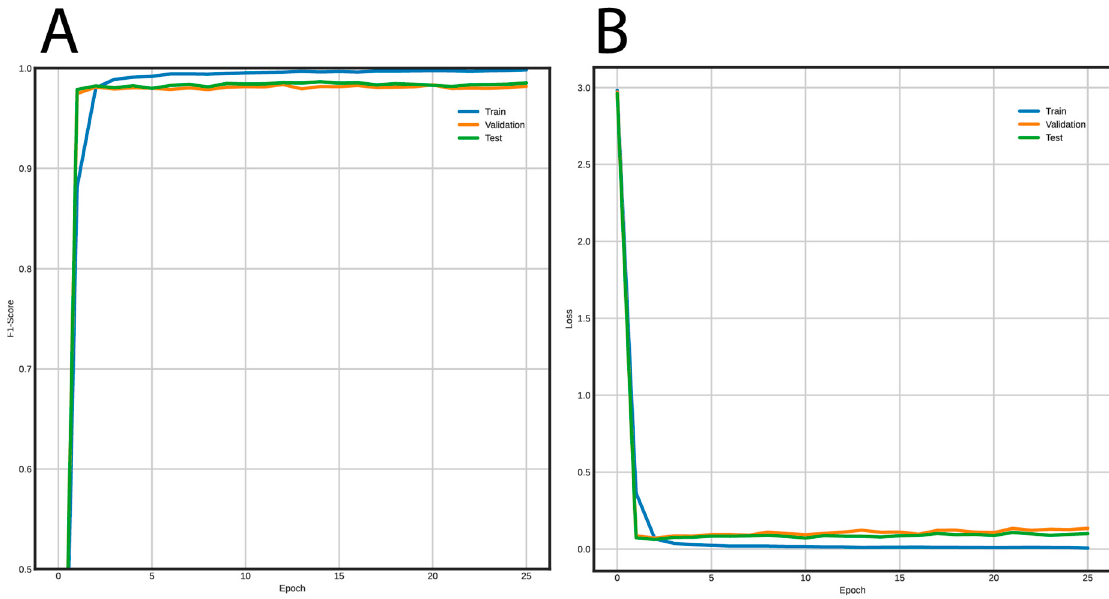
Figure 5. Learning curves using the FNN architecture to classify long terminal repeat (LTR) retrotransposons into lineages. ( A ) F1-Score vs. epochs, and ( B ) loss vs epochs.